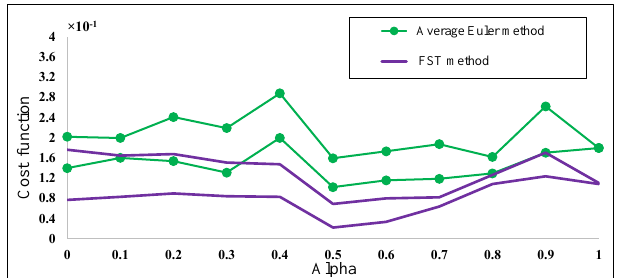
Figure 4. The lower and upper bounds of absolute